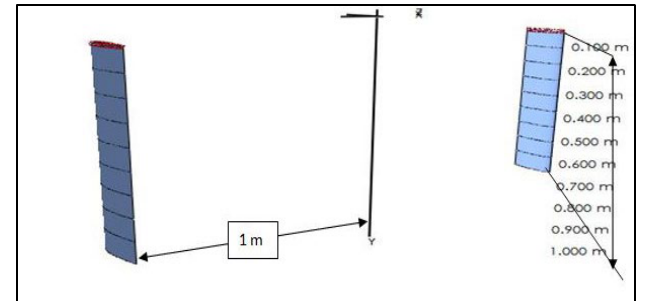
Figure 4. Three-bladed turbine model